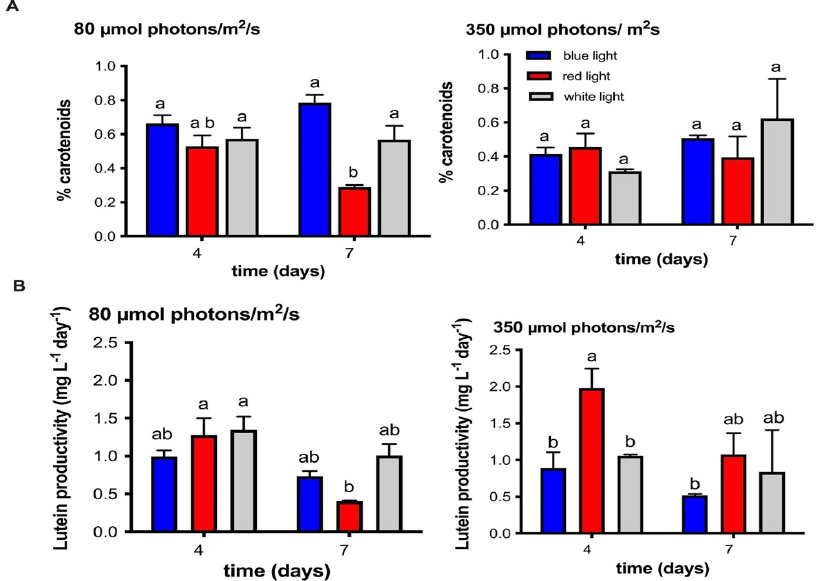
Figure 5. ( A ) Total content (% dry wt) of lutein, zeaxanthin, violaxanthin, astaxanthin, and beta- carotene obtained on days 4 and 7 in the microalgae extract of the MCH-35 grown under white, blue, and red light at irradiances of 80 and 350 µmol photons/m 2 / s. Each bar represents the average of four independent measurements. ( B ) Lutein productivity (mg L − 1 day − 1 ) on days 4 and 7 of the MCH-35 microalgae grown under different light wavelengths ( red, blue, and white) and irradiances of 80 and 350 µmol photons/m 2 / s. Each bar represents the average of four independent measure- ments. Statistically different values ( p = 0.05, ANOVA two-way, with Tukey posthoc test, n = 3) are indicated by a different letter for each irradiance condition. 2.4. Influence of Different Wavelengths and Irradiances on the Lipid Content